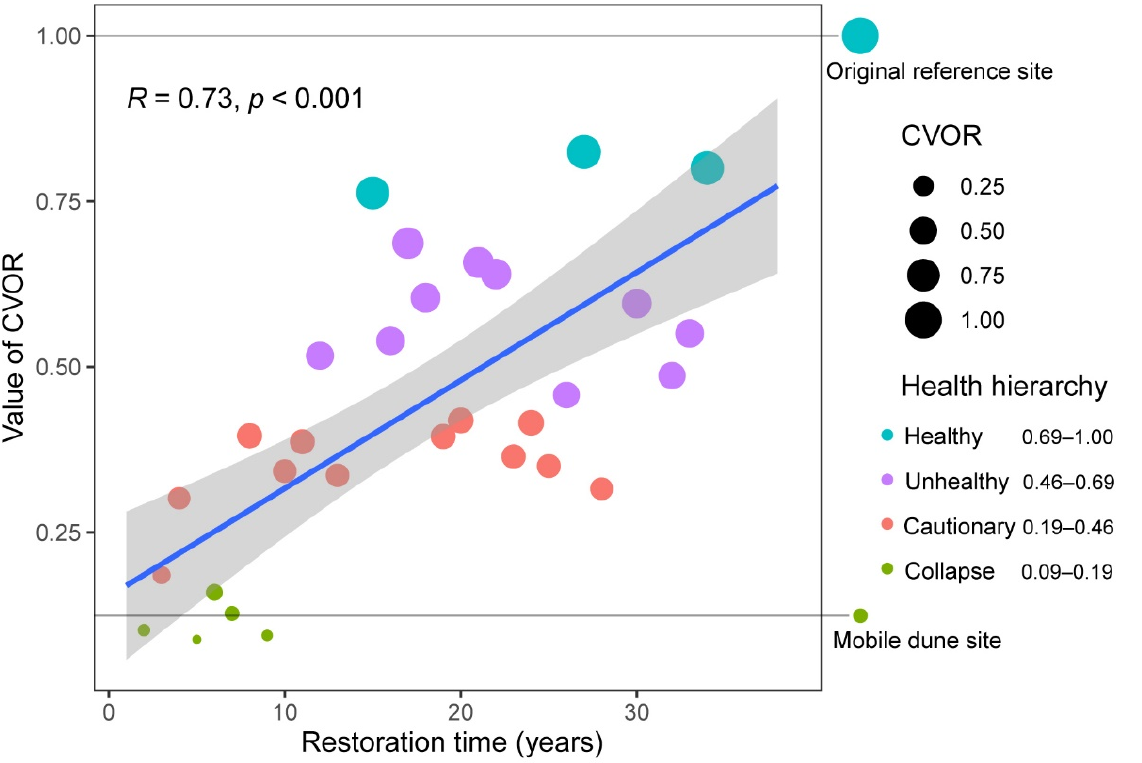
Figure 4. The correlation relationship between grassland ecosystem health (CVOR) and restoration time.